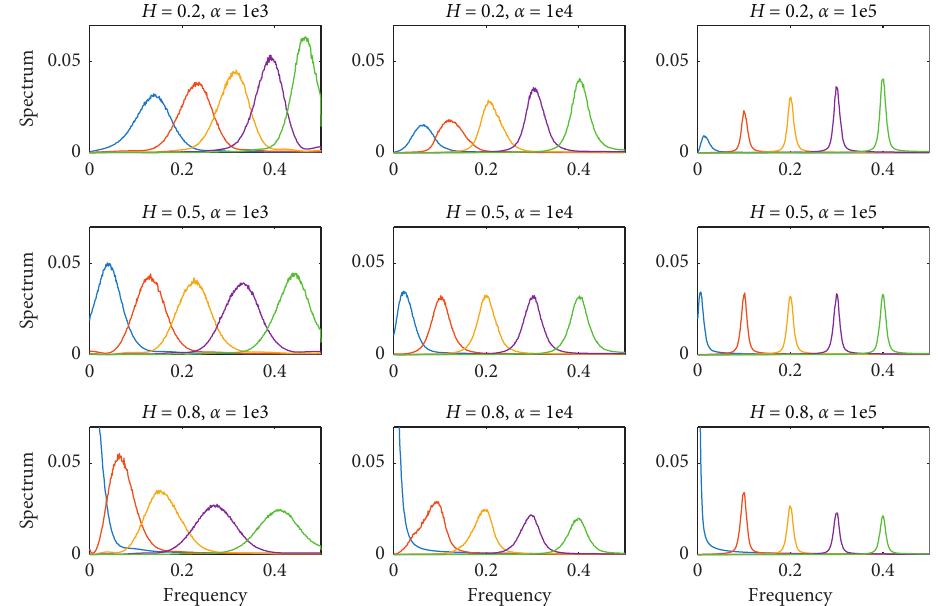
Figure 1: The averaged Fourier spectra of extracted modes u 􏼈 􏼉 for VMD realizations, in the case of three typical Hurst exponents: H � 0.2 k (1 st row), H � 0.5 (2 nd row), and H � 0.8 (3 rd row). The initial center frequencies ω 1 k 􏼈 􏼉 were uniformly distributed, for three different values of α ( α � 1e3 (1 st column), 1e4 (2 nd column), and 1e5 (3 rd